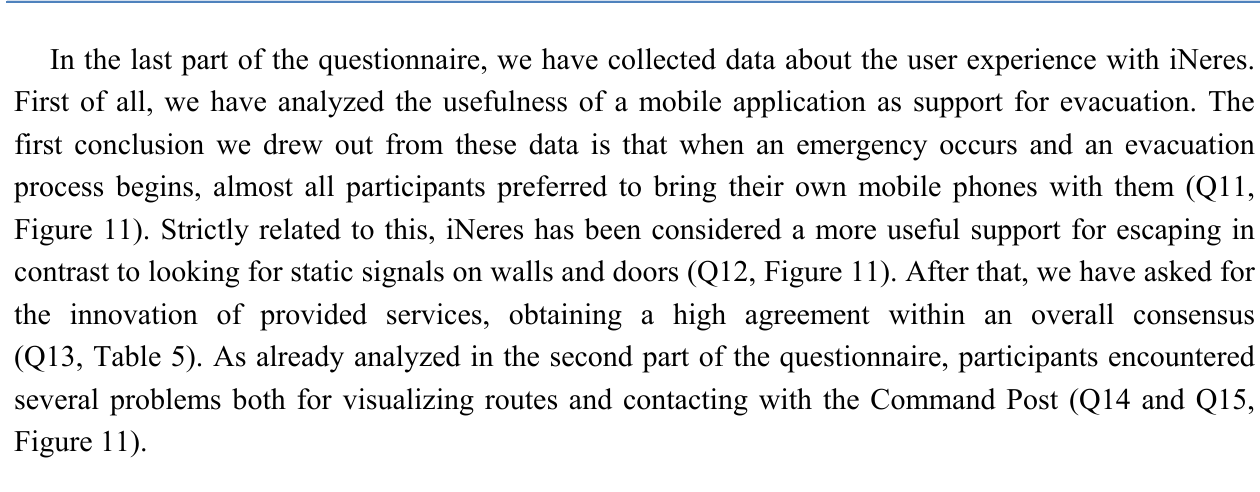
Figure 11. Graph visualization for results of the 4th part of the questionnaire (Q11, Q12, Q14, Q15).